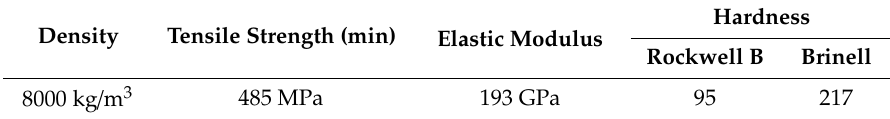
Figure 6. Hybrid external fixator system.